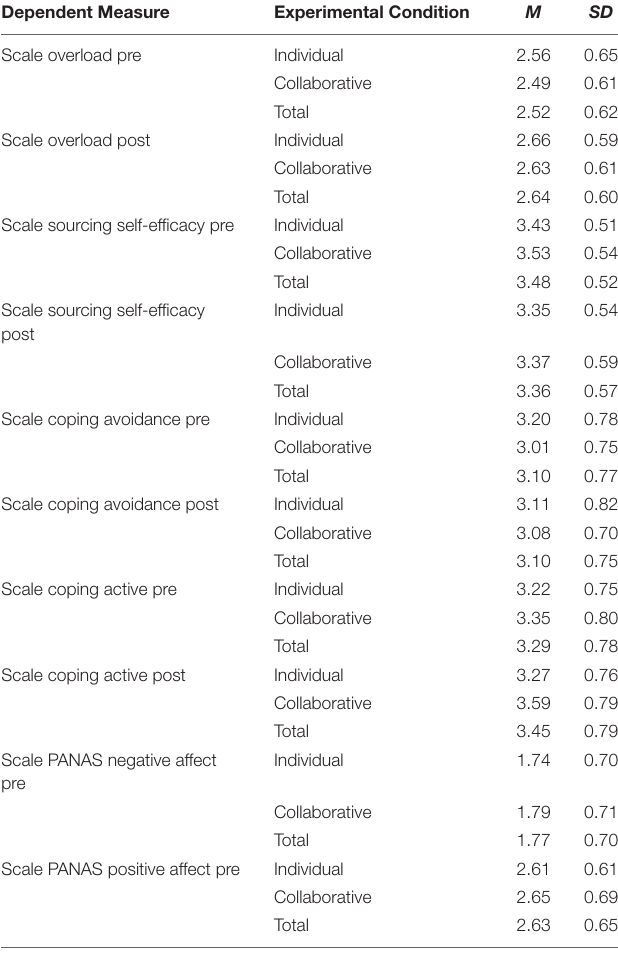
TABLE 3 | Descriptive values in terms of the